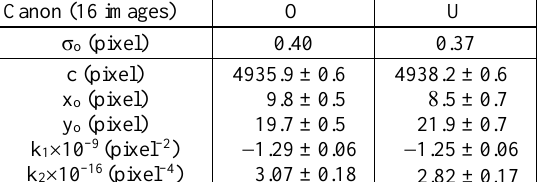
Table 4. Correlation coefficients ρ between c and k 1 , k 2 O: ordered patterns; U: unordered patterns